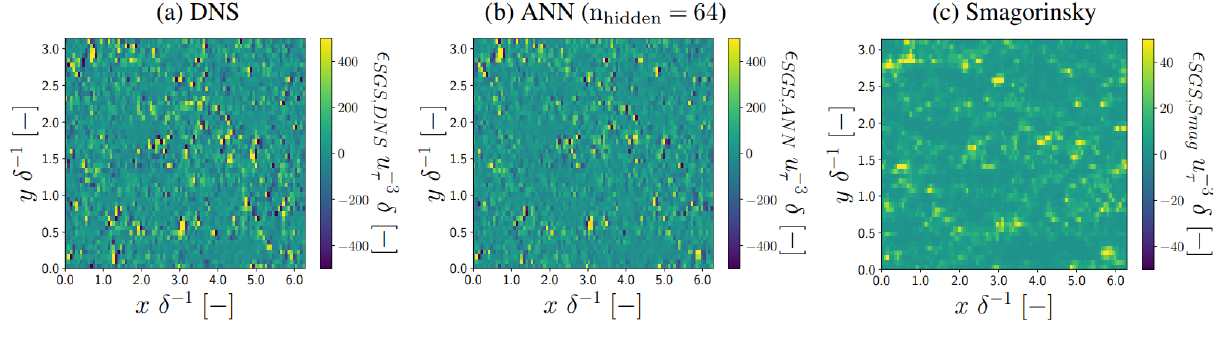
( 64 . 53125 z + ) ) for a representative flow field not used to train and δ